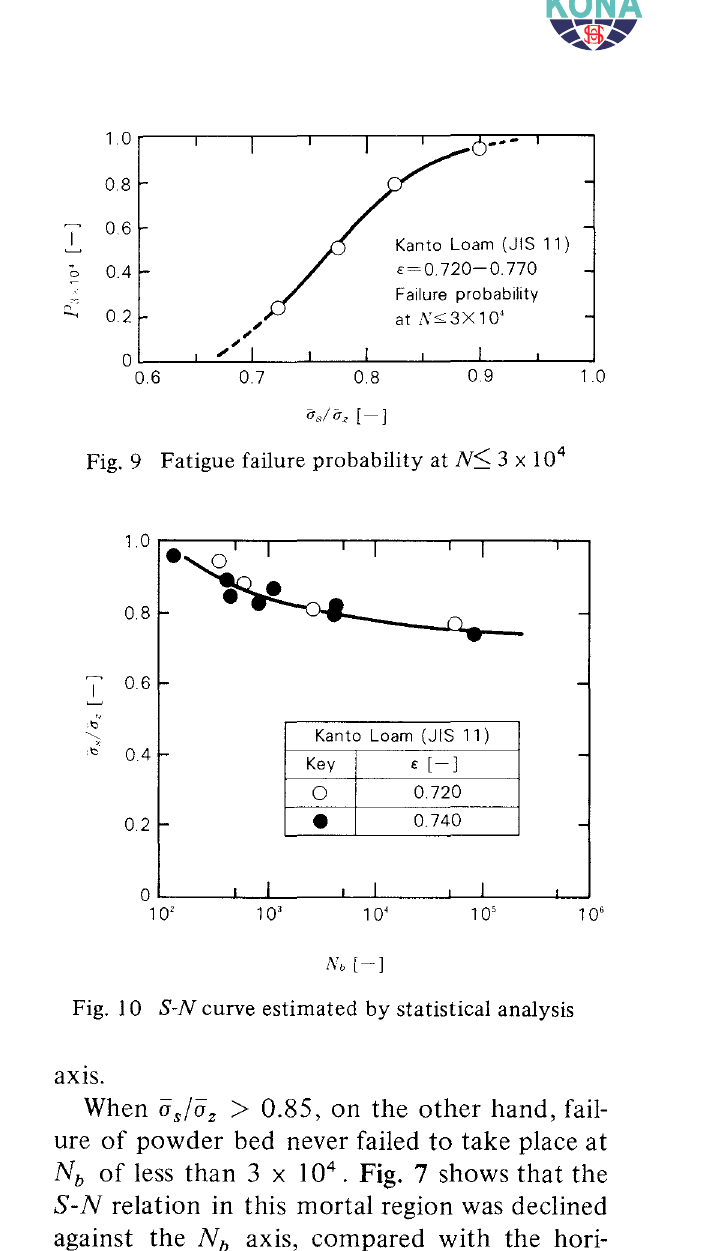
Fig. 10 S-N curve estimated by statistical analysis